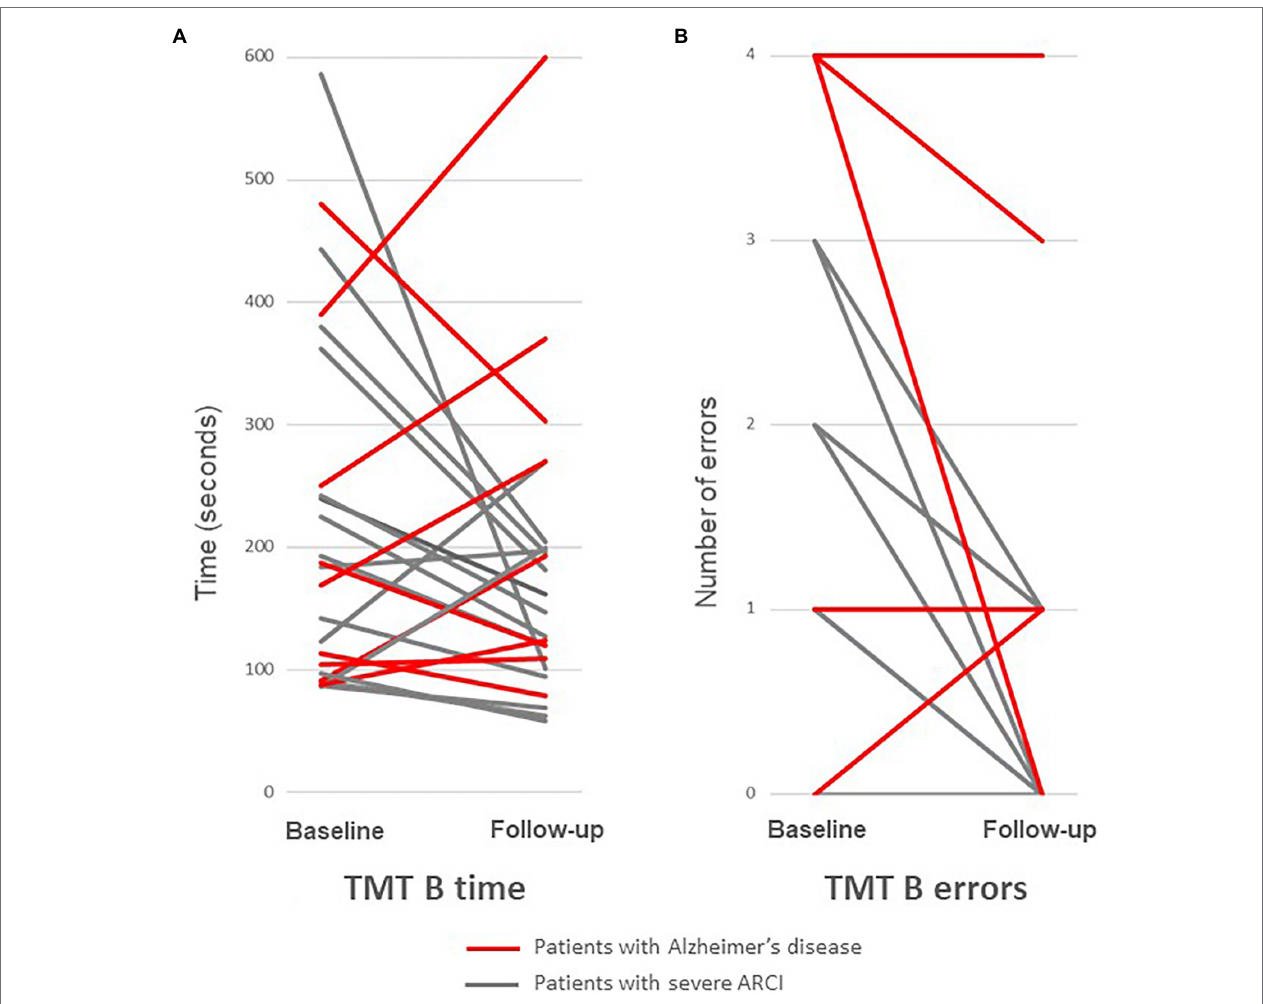
FIGURE 1 | Change in TMT-B test between baseline and follow-up in severe Alcohol-Related Cognitive Impairment (severe ARCI) group ( n = 13; in gray) and in Alzheimer’s disease group ( n = 10; in red): TMT-B time (A) and TMT-B errors (B) . Severe ARCI patients improve between baseline and follow-up (TMT-B time: p = 0.013 and TMT-B errors: p = 0.016, in Pair-wised Wilcoxon test), while AD patients were